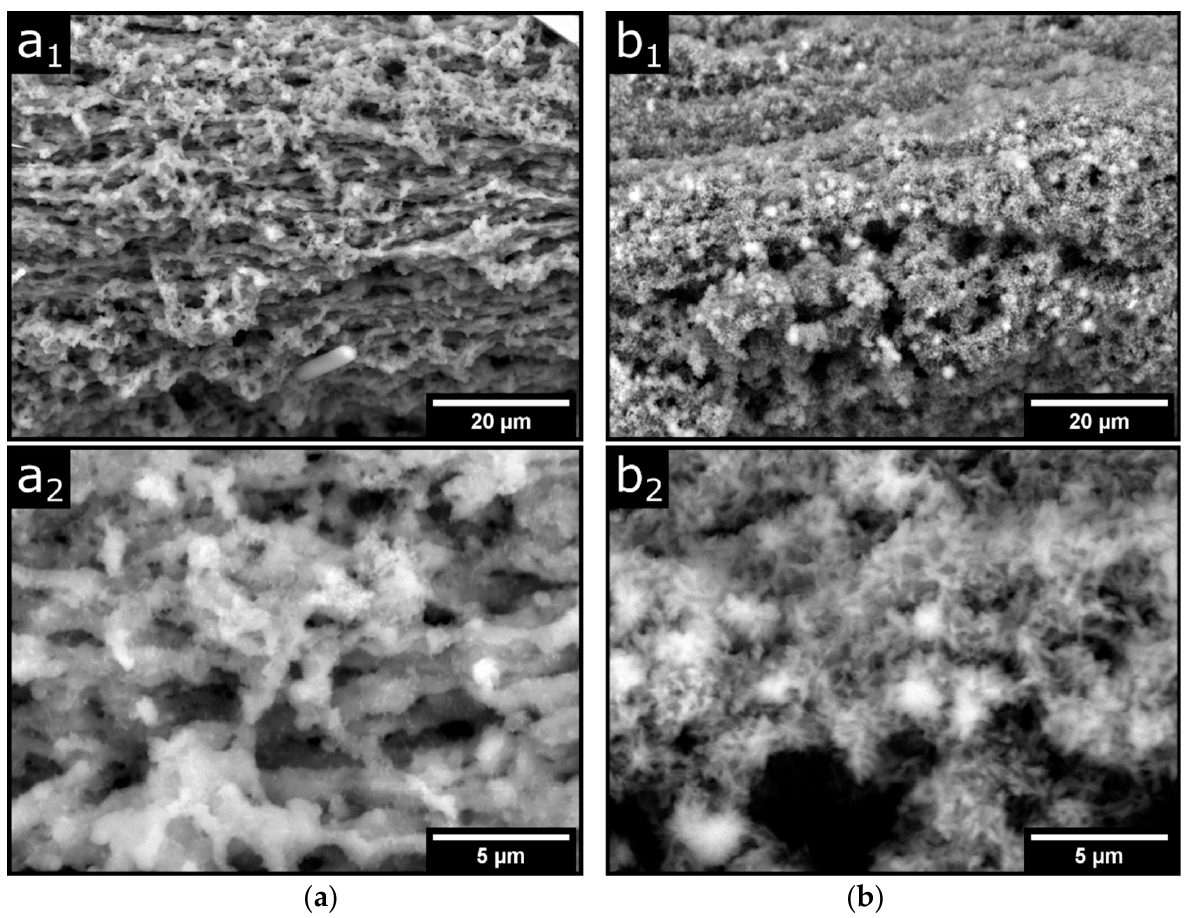
Figure 5. Scanning electron micrographs of dried p -CMs fibers post-treated with TGase and spun with ( a ) 1% and ( b ) 10% glycerol in 50 mM CaCl 2 . ( a 1 ) and ( b 1 ): × 2000 magnification, ( a 2 ) and ( b 2 ): × 8000 magnification